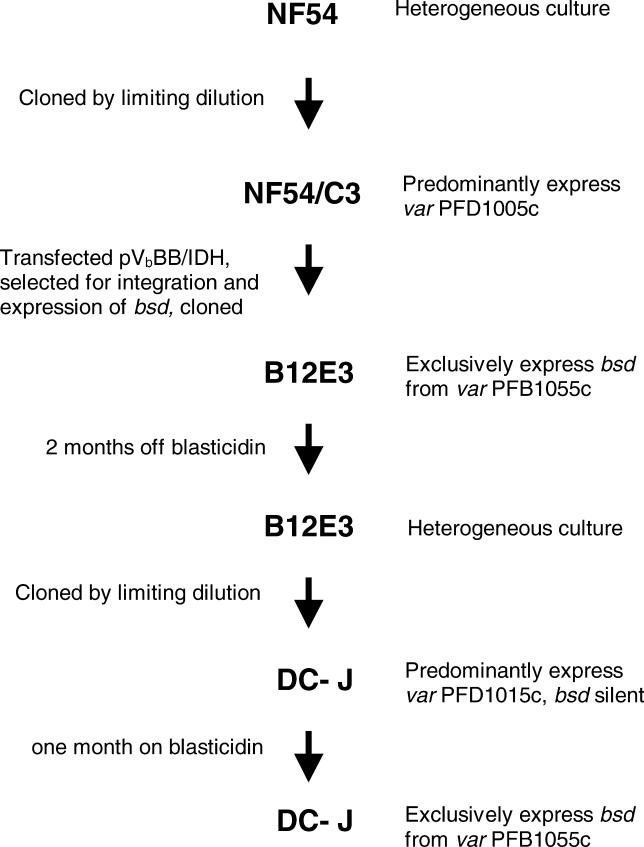
Outline of Experimental DesignNF54 parasites were cloned by limiting dilution to create a clonal population (NF54/C3) that predominantly expressed PFD1005c. These parasites were transfected with the plasmid pVbBB/IDH and the clone B12E3 containing a double crossover integration was isolated. After blasticidin selection, B12E3 exclusively expressed bsd, and all other var genes were transcriptionally silent. Drug pressure was then removed for two months during which time the var gene expression pattern became heterogenous. This heterogeneous B12E3 population was then re-cloned and clone DC-J isolated. DC-J predominantly expressed the var gene PFD1015c and had silenced the bsd gene. Growth of DC-J back under blasticidin pressure however results in reactivation of bsd expression and silencing of the rest of the var gene family, thus demonstrating the reversibility of the phenomenon.